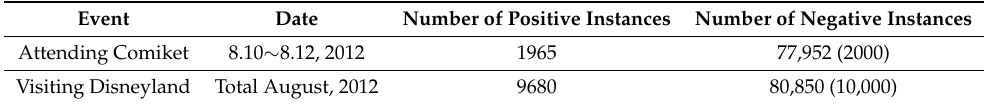
Table 2. Dataset